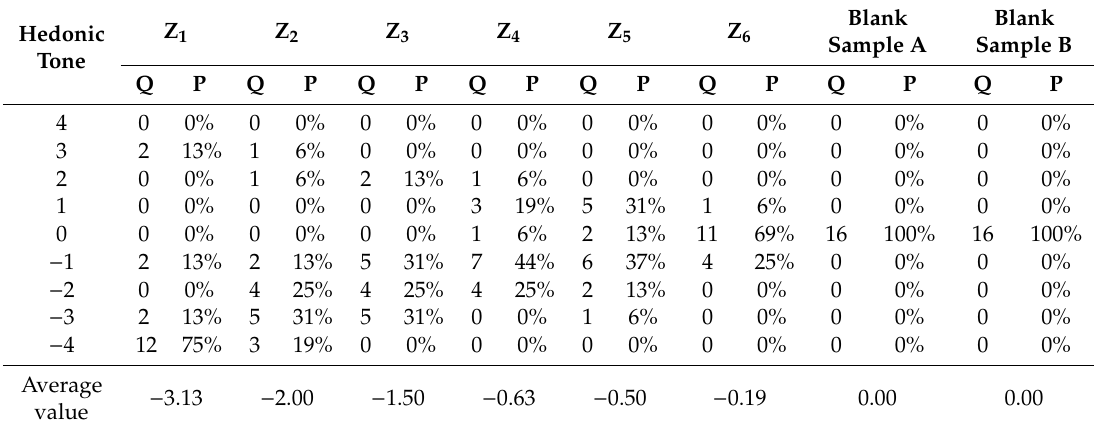
Table 4. The result of the hedonic tone evaluation for butyl acetate; the OC of the original sample is 17,378 OU E · m − 3 . The dilution times from Z 1 to Z 6 are respectively 0, 10, 30, 100, 300 and 1000.